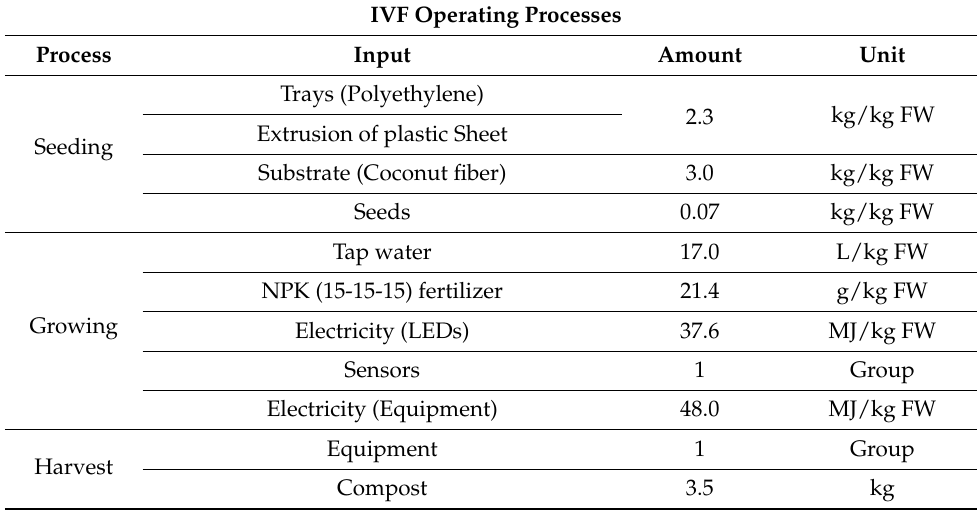
Table 2. LCI of the processes applied for IVF operations with the system boundary 6 processes: Seeding, Growing, Harvest, Packaging, and Delivery are provided with material inputs. Units describe the total volume of inputs per kilograms of fresh weight (kg/kg FW), electricity is measure in megajoules per fresh weight (MJ/kg FW), water in liters (L/kg FW) and kilometers for transportation (km/kg FW) (More detailed in Tables S5 and